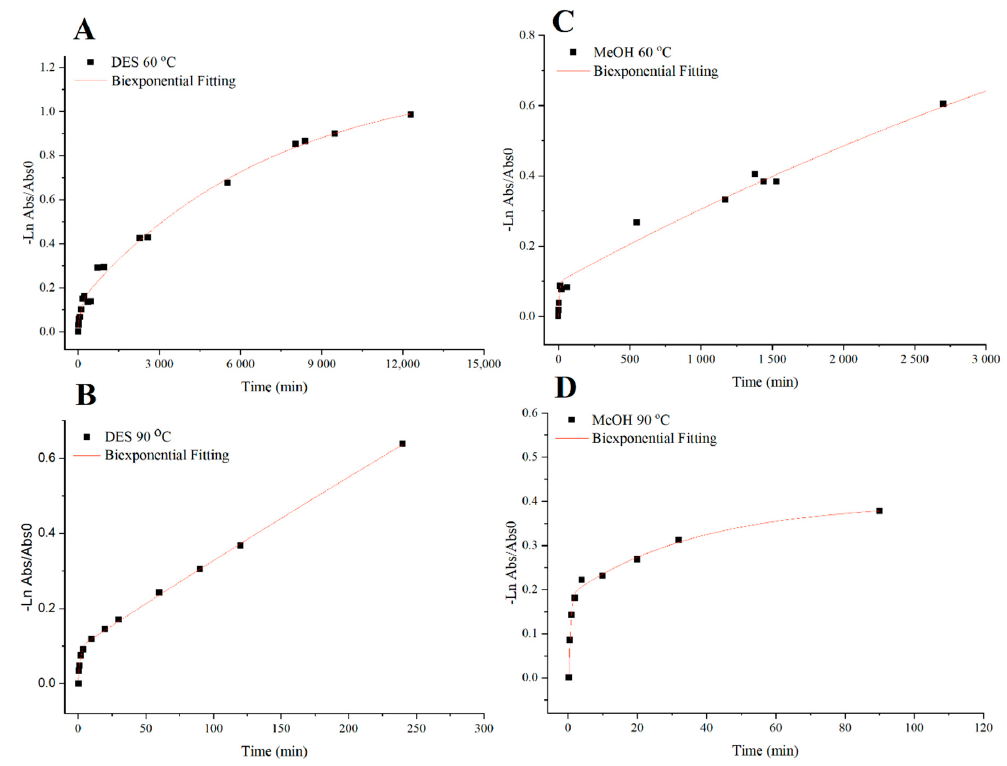
Figure 3. Degradation kinetics of anthocyanins extracted with Ch-Xyl ( A , B ) and MeOH ( C , D ) at 60 °C and 90 °C. The correlation coefficients of all curves are R 2 ≥ 0.99.